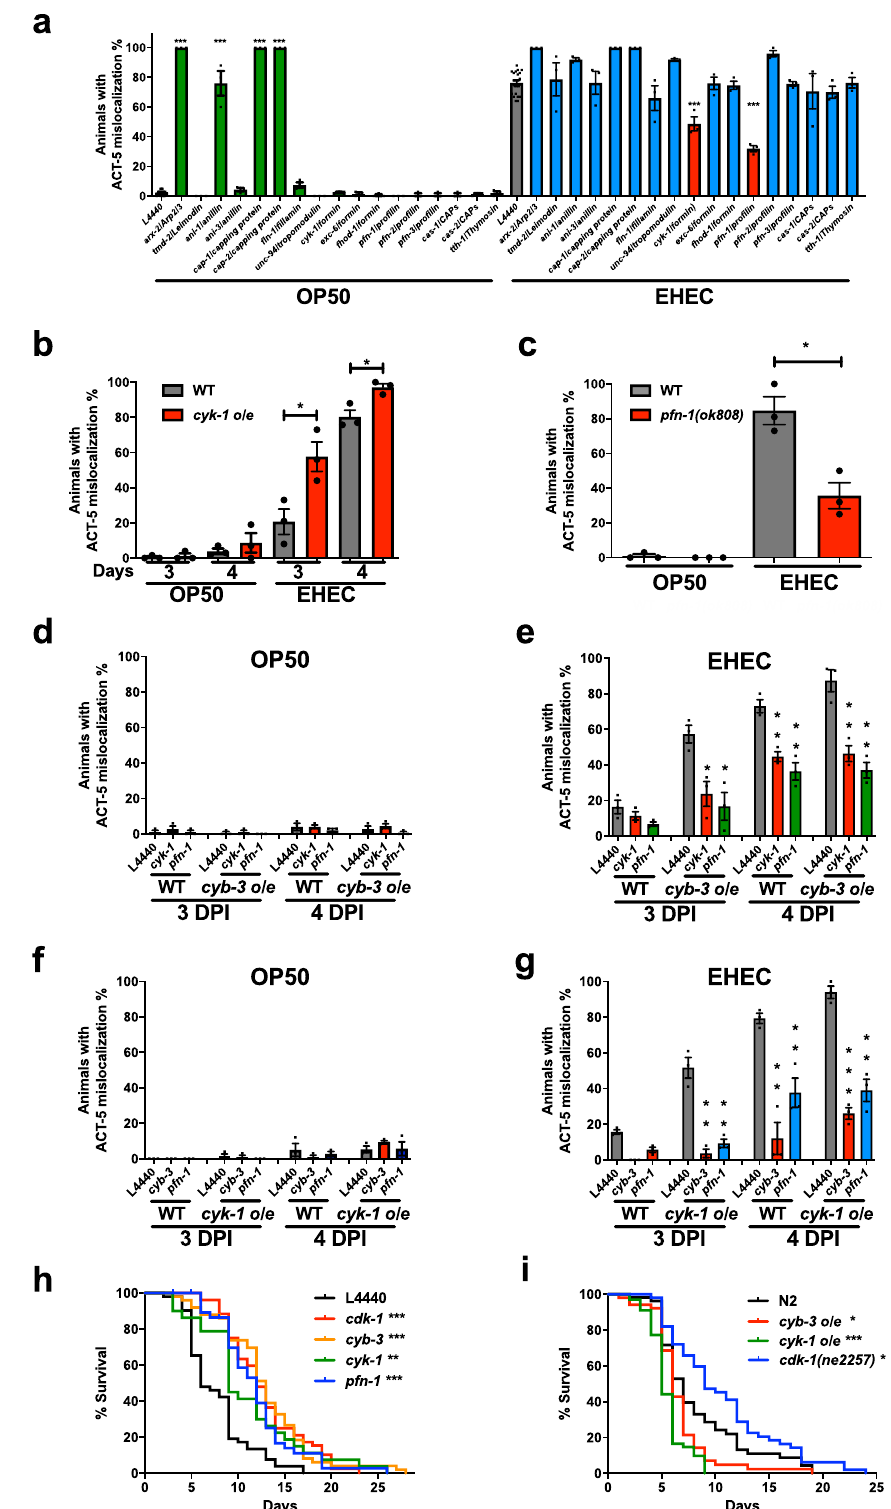
These results not only recon fi rmed the dynamic nature of these basolateral mC::ACT-5 punctae as F-actin structures but also recon fi rmed that the CYB-3/CDK-1-CYK-1/PFN-1 signal is required for the EHEC-induced ACT-5